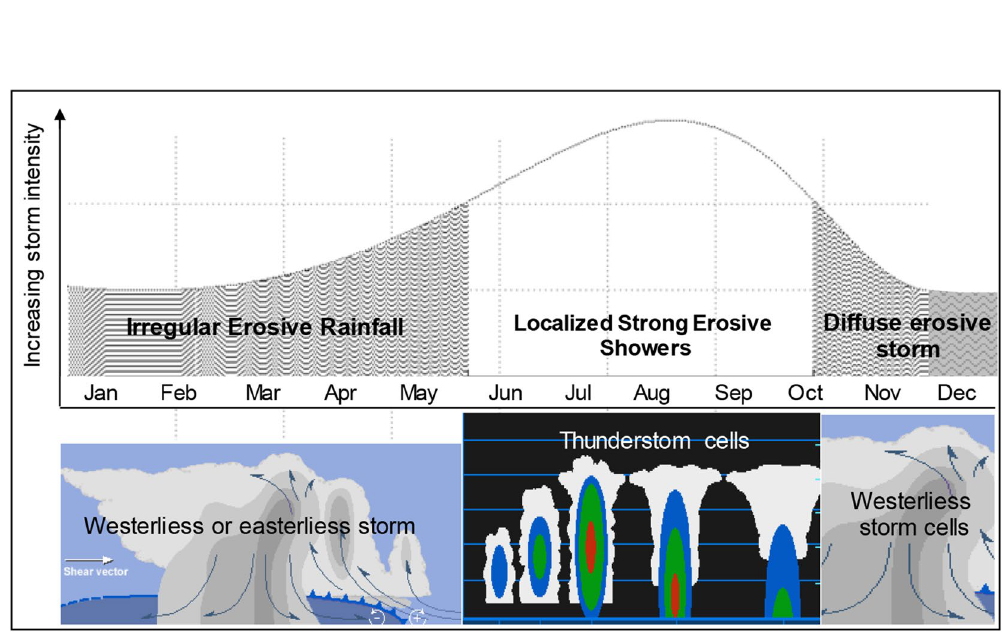
Figure 6. Seasonal regime of storm cells with the related scheme of variability of the monthly storm erosivity strength over the